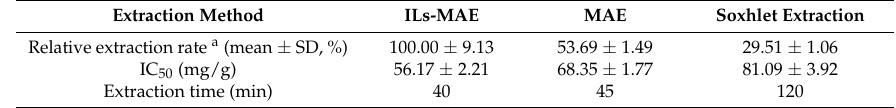
Table 3. Comparison of different extract methods on total biflavonoids content and IC 50 values. Extraction Method ILs-MAE MAE Soxhlet Extraction Relative extraction rate a (mean ± SD,